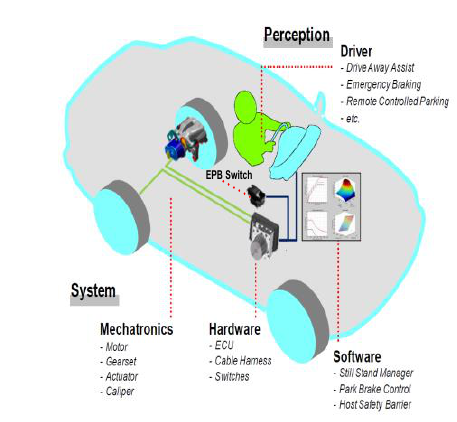
Figure 2 Electric Parking Brake System [1]